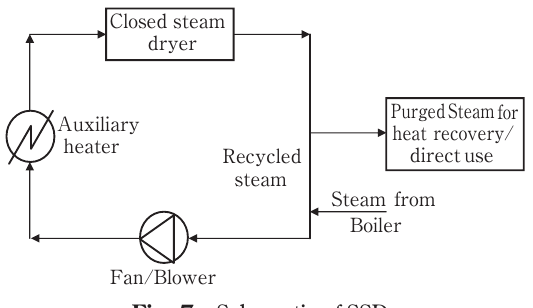
Fig. 7 Schematic of